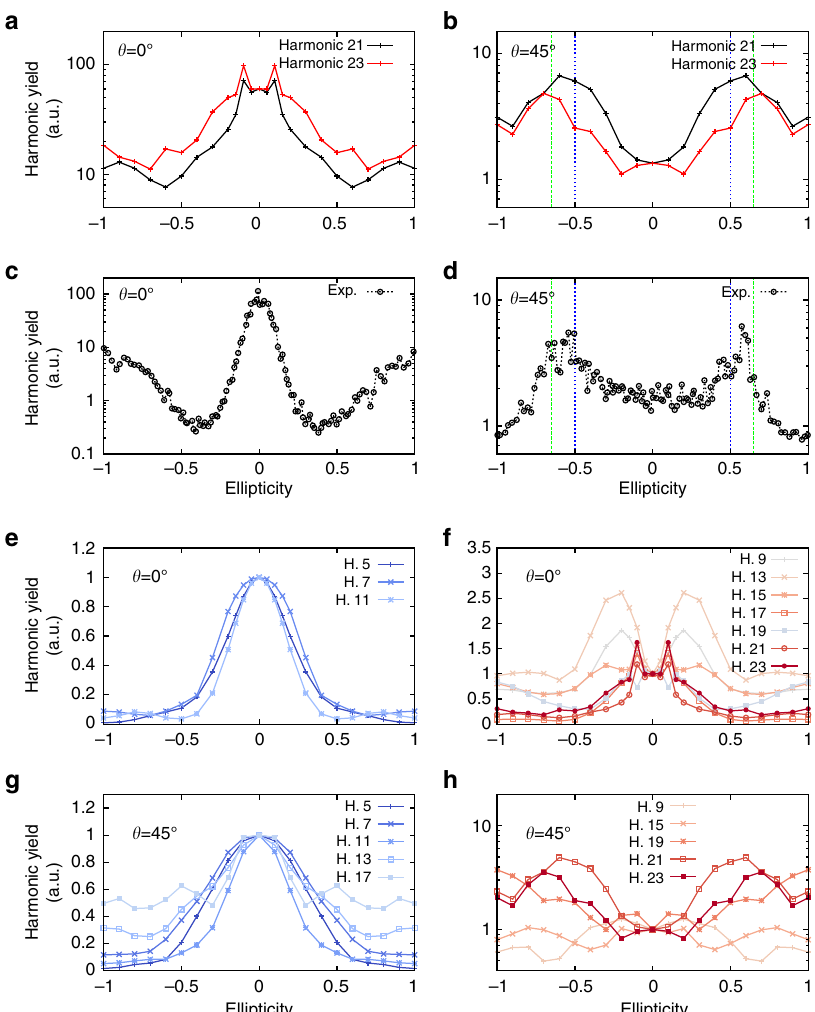
Fig. 2 Ellipticity dependence of the harmonic yield for different harmonics of bulk MgO. a – d Computed ellipticity dependence of the harmonics 21 ( black lines ) and 23 ( red lines ) generated from bulk MgO ( a , b ) vs. the experimentally observed ellipticity dependence of harmonic 19 ( c , d ) taken from ref. 36 . As in Fig. 1, θ = 0° corresponds to the Γ X direction. Vertical lines in b , d showing the case of the Mg – O direction ( θ = 45°) indicate the positions of ϵ = ± 0.5 and ϵ = ± 0.65. e – h Ellipticity dependence of various harmonics, for the major axis of the polarization ellipse at θ = 0° ( e , f ) and θ = 45° ( g , h ). The harmonics are divided into a group of mostly atomic-like ( e , g ) and non-atomic-like harmonics ( f , h ), the latter exhibiting a pronounced increase of the harmonic yield at non-zero values of